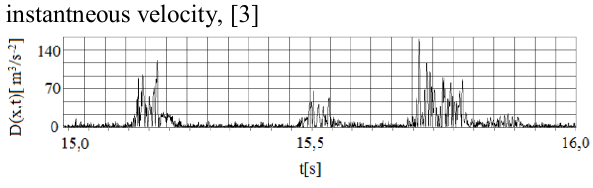
Fig. 4. Detector function